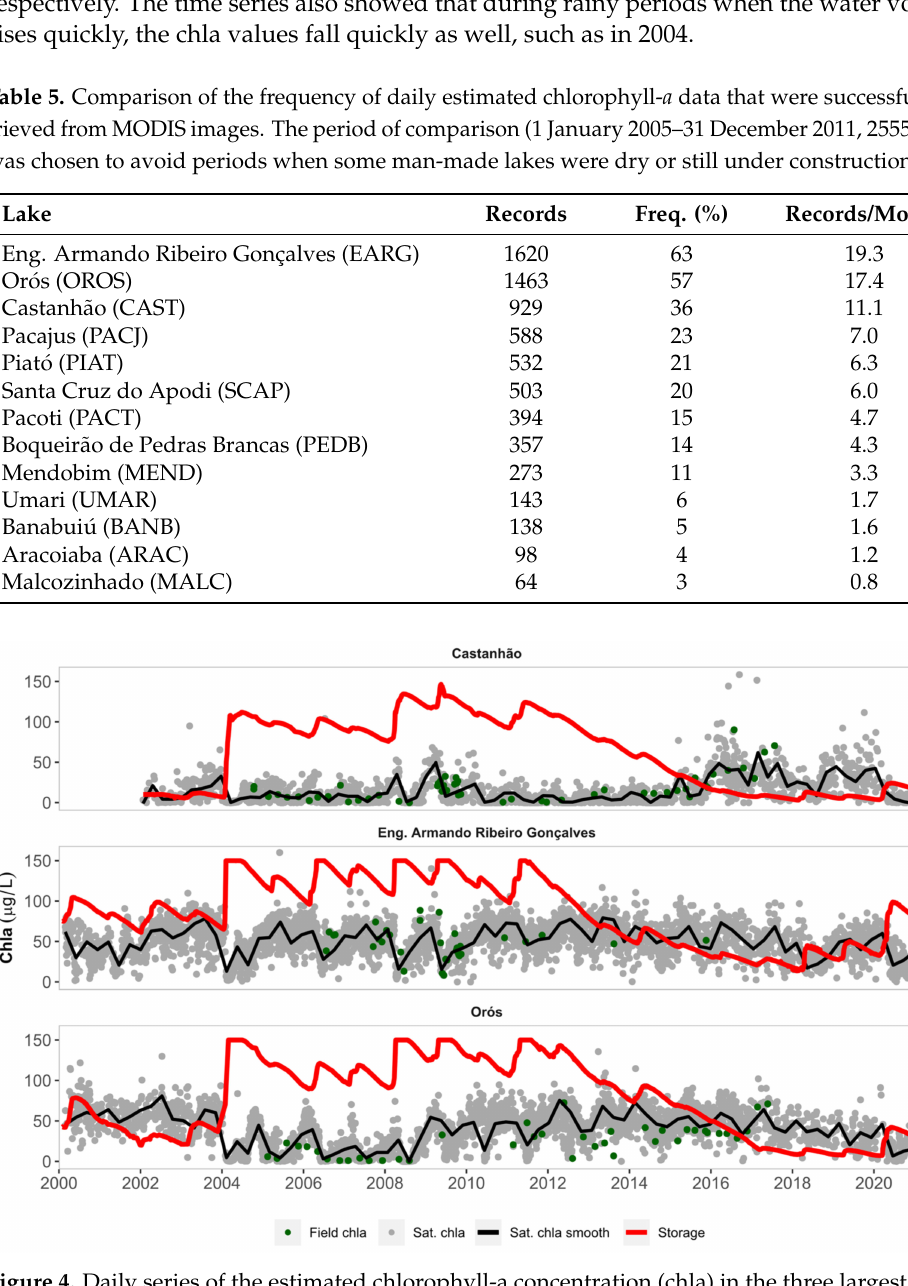
Figure 4. Daily series of the estimated chlorophyll-a concentration (chla) in the three largest study lakes. A smooth line for the chla estimations is shown. The field chla observations and the daily records of lake storage, in percent of the storage capacity, are also shown. The Castanh ã o series start later than the others because the dam was under construction until late